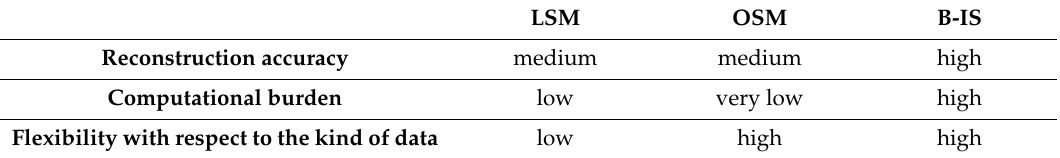
Table 1. Summary of strong and weak points of the three solution methods.